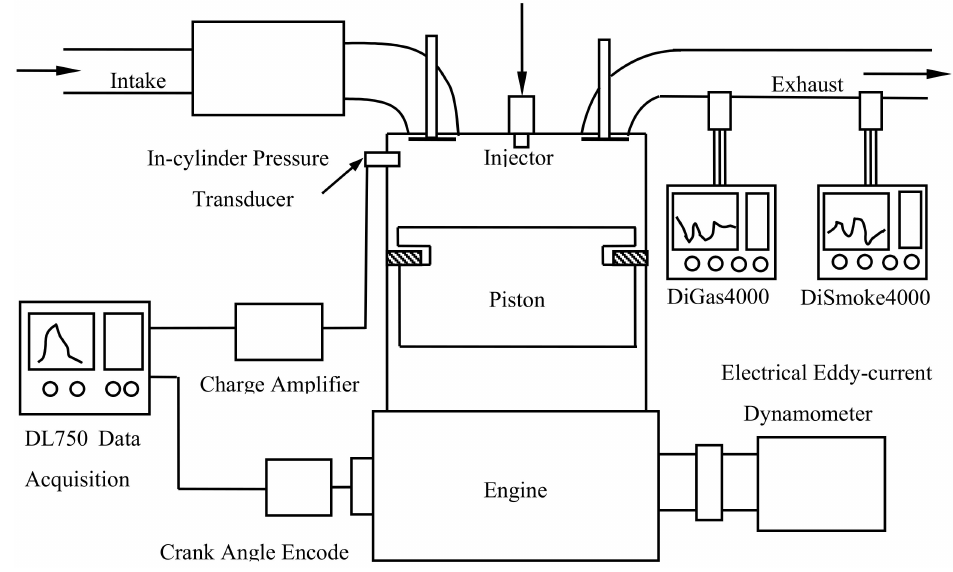
Figure 6. Experimental setup for engine